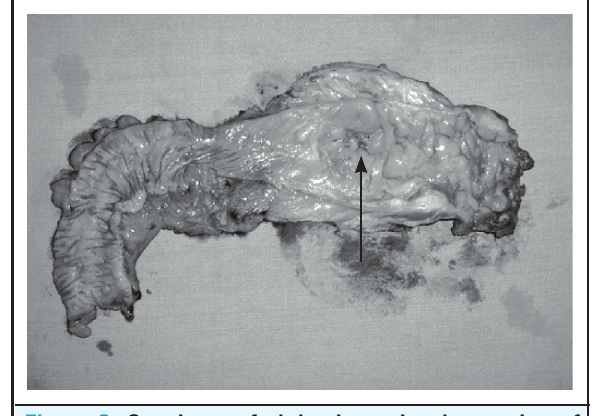
Figure 2. Specimen of abdominoperineal resection of the rectum showing the growth with an area of ul - ceration at the middle third of the rectum (arrow).